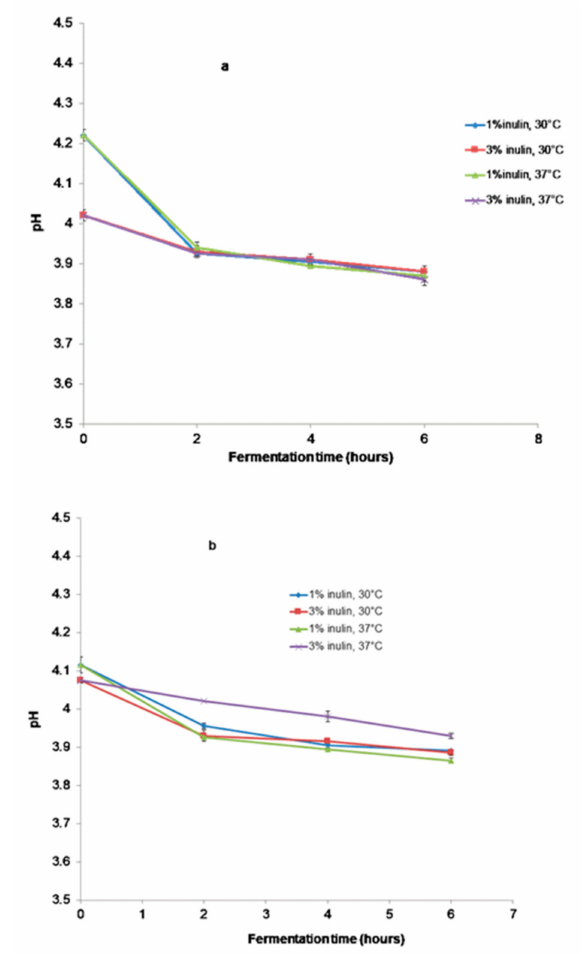
Figure 2. pH changes in beverages during fermentation ( a ) Samples with SBS; ( b ) Samples with